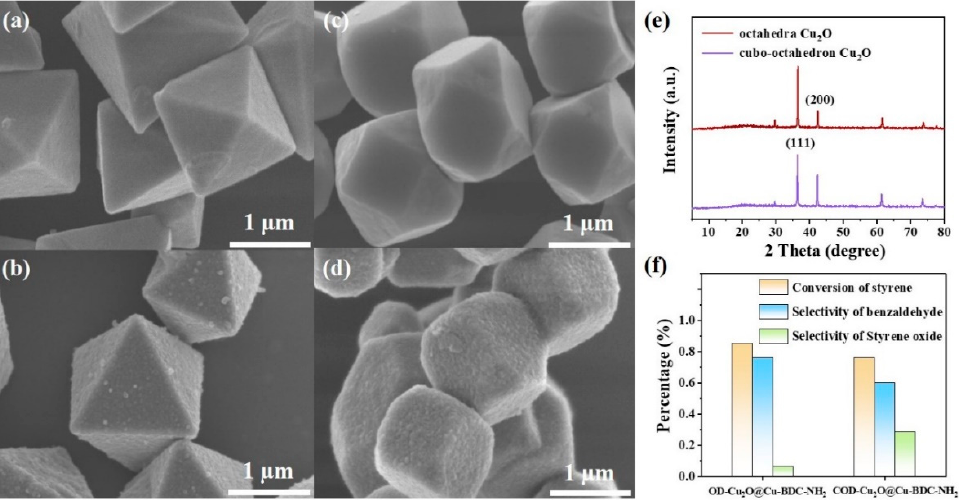
Figure 7. SEM images of ( a ) od-Cu 2 O, ( b ) od-Cu 2 O@Cu-BDC-NH 2 , ( c ) cod-Cu 2 O, and ( d ) cod- Cu 2 O@Cu-BDC-NH 2 . ( e ) XRD patterns of od-Cu 2 O and cod-Cu 2 O. ( f ) The catalytic performance of od-Cu 2 O@Cu-BDC-NH 2 and cod-Cu 2 O@Cu-BDC-NH 2 in the selective oxidation of styrene to ben- zaldehyde.